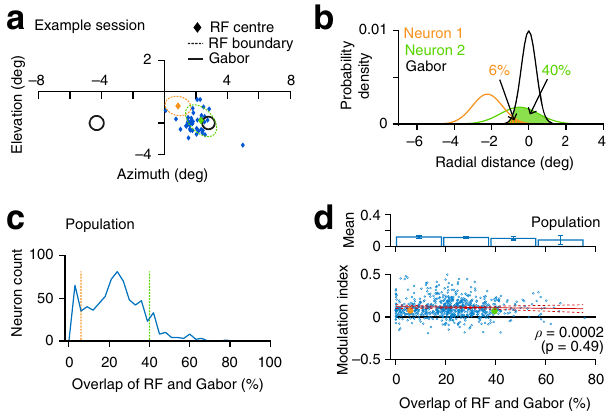
Fig. 4 Spatial distribution of neuronal modulation associated with spatially nonselective attention. a Centers of visual receptive fi elds (RF) of all recorded units in one example session. Black circles, Gabor sample stimuli (1 standard deviation (SD)). Dashed circles, size of RFs (1 SD) of two example neurons. b Overlaps of the probability densities of RFs and attended Gabor sample stimuli for two example neurons in ( a ) (see “ Methods ” ). The proportion of overlap measures the proximity of the RF relative to sample stimuli. c Population distribution of the overlaps of RFs and Gabor stimuli across all units ( n = 731). Dashed lines, two example neurons in ( a , b ). d Bottom, correlation between neuronal modulation (neuronal d ′ , Fig. 3d) and the proximity of RF and Gabor stimulus ( ρ = 0.0002, p = 0.49; Spearman correlation, two-sided t -test). Red line, linear regressor (with 95% con fi dence intervals). Filled circles, example neurons in ( a ). Top, mean modulation indices of units grouped in four equal intervals of RF-Gabor overlaps. There was no difference among these groups ( F (3, = 0.67, p = 0.57; one-way ANOVA). n = 731 units from monkey P and 730) monkey S. Data are presented as mean with 95% con fi dence